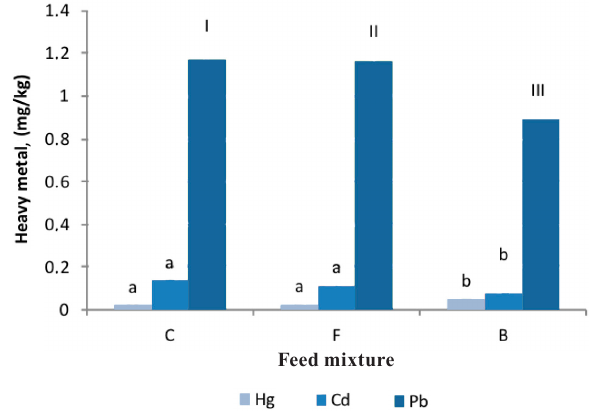
Figure 3 Heavy metal concentrations in muscle tissue of farmed rainbow trout in relation to the type of commercial feed mixture (C: pellet I; F: pellet II; B: pellet III). All results are expressed as means ± SD for six fish in each group. a and b: groups with different letters differ significantly ( P <